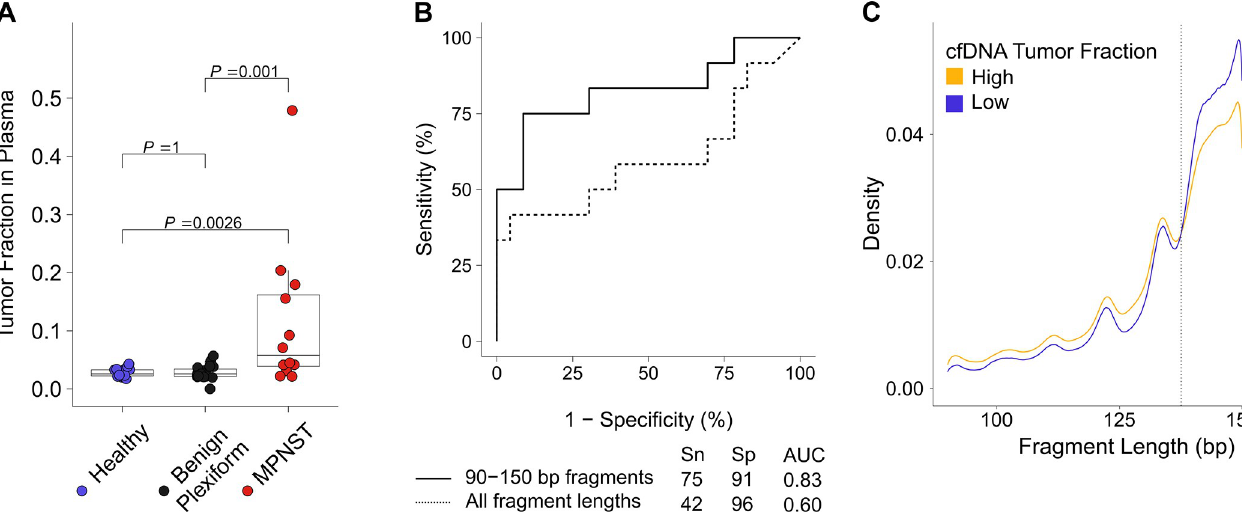
Fig 4. Tumor fraction in plasma stratifies patients by diagnosis. (A) Tumor fraction in participants with available pretreatment plasma cfDNA ( n = 53), stratified by clinical diagnosis, with significance assessed by the Dunn test after Kruskal–Wallis analysis of variance. (B) ROC curve of plasma cfDNA tumor fraction comparing pretreatment MPNST to PN patients. Solid line represents tumor fraction data derived only from 90–150 bp fragments, while dotted line represents tumor fractions derived from all fragment lengths. Confusion matrix is reported separately ( S5 Table ). (C) Fragment length density for cfDNA in MPNST and PN patients ( n = 69 samples) with high ( > 0.0413) versus low ( < 0.0413) tumor fractions in plasma as determined by the Youden’s index- optimized cutpoint from the ROC curve. The dashed line highlights an inflection in the curves with high tumor fraction samples enriched for shorter cfDNA fragment sizes ( < 138 bp) and low tumor fraction samples enriched for longer cfDNA fragment sizes ( D = 0.078, P < 0.001 by two-sample Kolmogorov– Smirnov test). Data are shown for sequencing reads within the 90 to 150 bp in silico size-selection range ( Methods ). AUC, area under the curve; bp, base pairs; cfDNA, cell-free DNA; MPNST, malignant peripheral nerve sheath tumor; PN, plexiform neurofibroma; ROC, receiver operating characteristic; Sn, sensitivity; Sp, specificity.